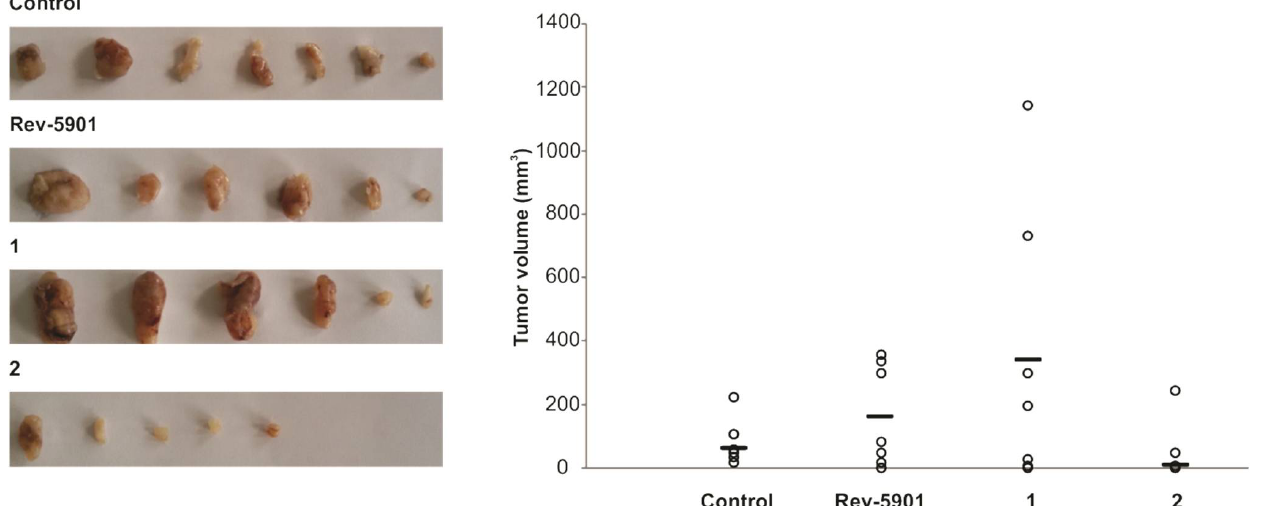
Figure 4. Treatment with 2 results in a significant reduction in tumor volume. Tumors were induced by implantation of CT26CL25 cells in BALB/c mice. Compounds 1 , 2 and Rev-5901 were injected i.p. for 15 consecutive days starting on day 10 after tumor implantation. Tumors were harvested 25 days after tumor implantation, and their volume was calculated by the formula: (length × width 2 ) × 0.52. Statistical significance: 2 vs. control p = 0.03, 2 vs. Rev-5901 p = 0.048 and 2 vs. 1 p = 0.048. The solid line represents the mean tumor volume for each group.